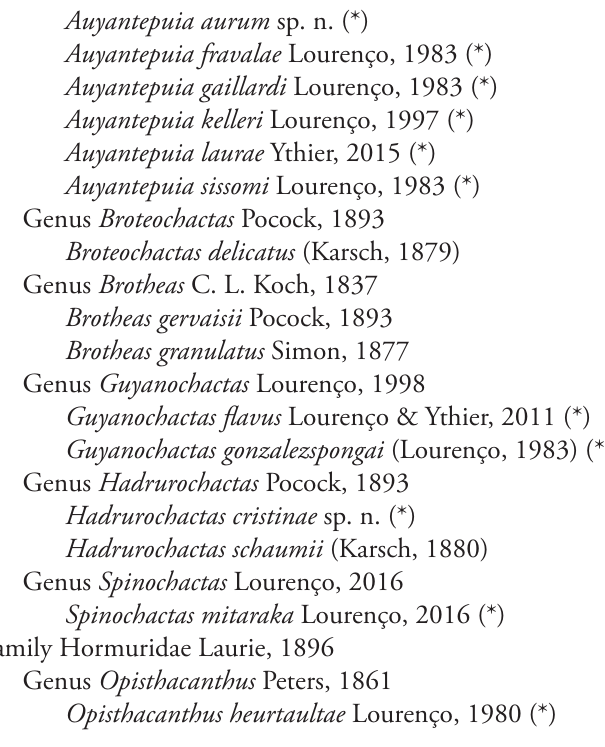
Fig. 1 References. Lourenço 1982, Lourenço and Cuellar 1999, Fet et al. 2000, Lourenço 2003a. Material. Downstream from Saut Pararé on Arataye river, Approuague tributary, one female (holotype), MNHN-RS-8504, J.P. Gasc coll., IV-V/1979. Right bank